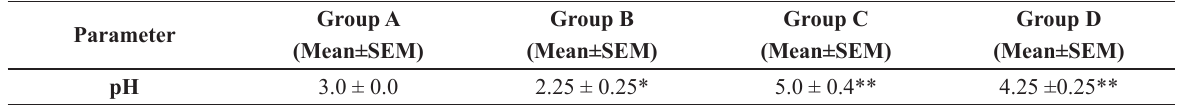
Determination of the pH of gastric contents from negative control (group A), positive control (group B), standard drug control (group C) and extract treated group of rats (* P <0.05; compared to negative control group, ** P <0.05 compared to positive control group;